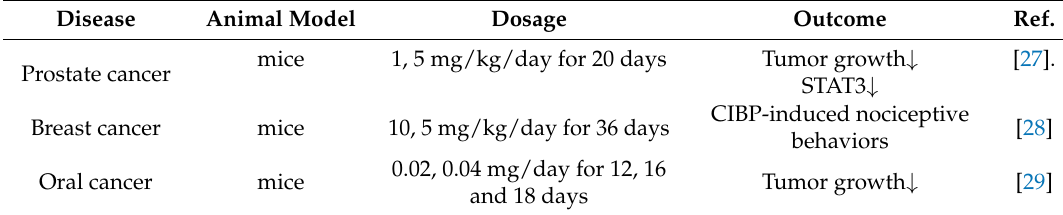
Table 2. Anti-cancer effects of Capsazepine on animal